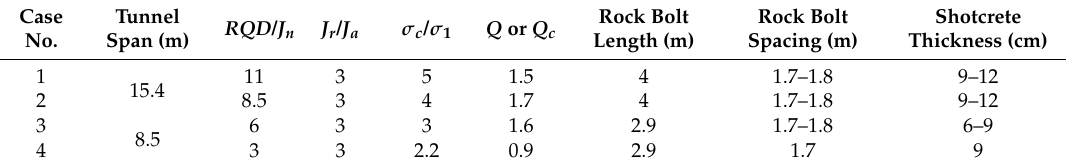
Table 10. Recommended empirical supports for two tunnel projects using the Q system. Case No.